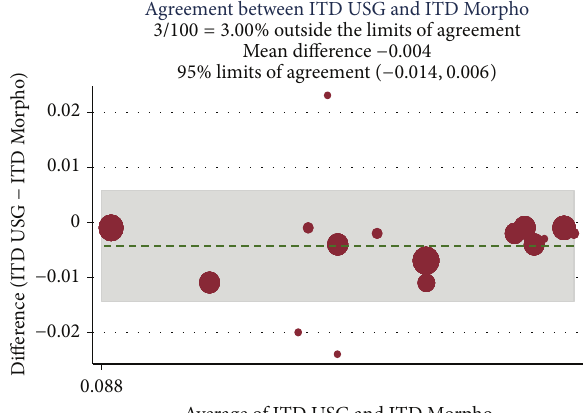
Figure 2: ICC was 0.90 with mean difference of − 0.004; limit of agreement was 95% with upper and lower limits of − 0.014 and 0.006. 3% values are above the limit of agreement, which means both methods are in